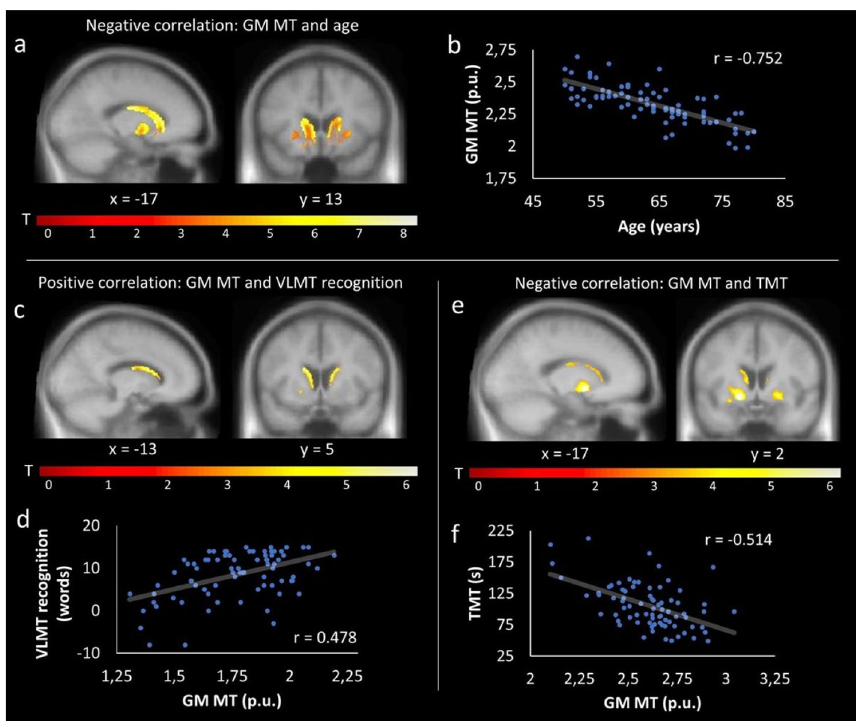
Figure 5. Relationship between GM MT, age, and cognitive performance. SPMs showing a significant negative relationship between GM MT and age within left and right caudate ( a ); a positive relationship between GM MT and VLMT recognition within the left and right caudate ( c ); and a negative relationship between GM MT and TMT within the left and right pallidum ( e ). The corresponding correlation plots for the clusters are shown in ( b , d , f ). For display purposes, SPMs were thresholded at p < 0.001, uncorrected, and superimposed on the mean T1-weighted